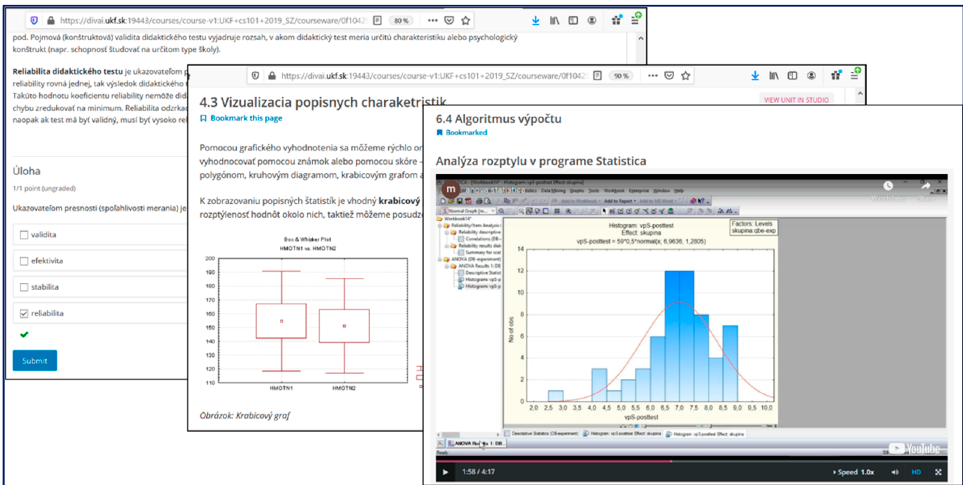
Figure 2. Example from the course—content, video, quiz.